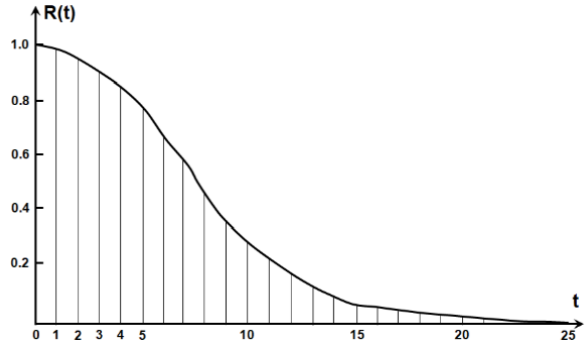
Figure 2. Reliability function R(t).